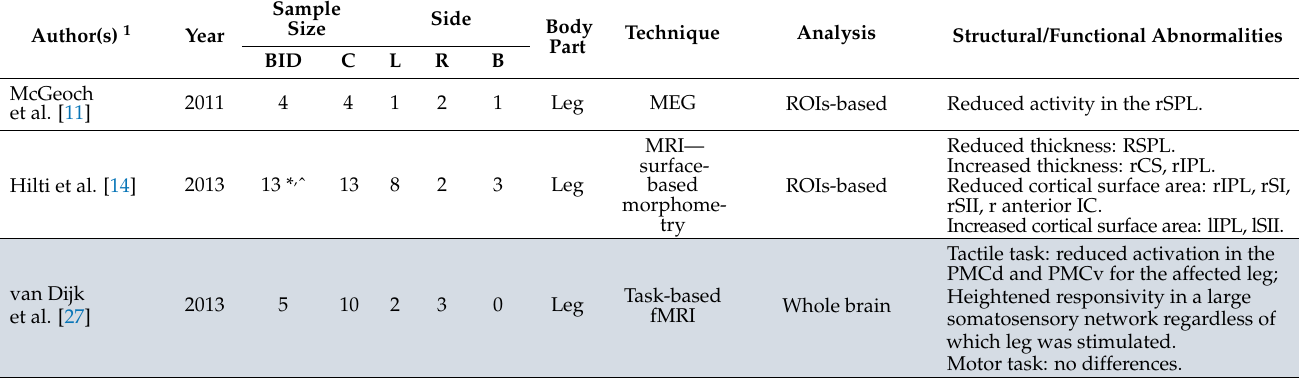
Table 1. List of studies that have investigated the neurofunctional bases of BID using neuroimaging techniques. Author(s) 1 Technique Analysis Structural/Functional